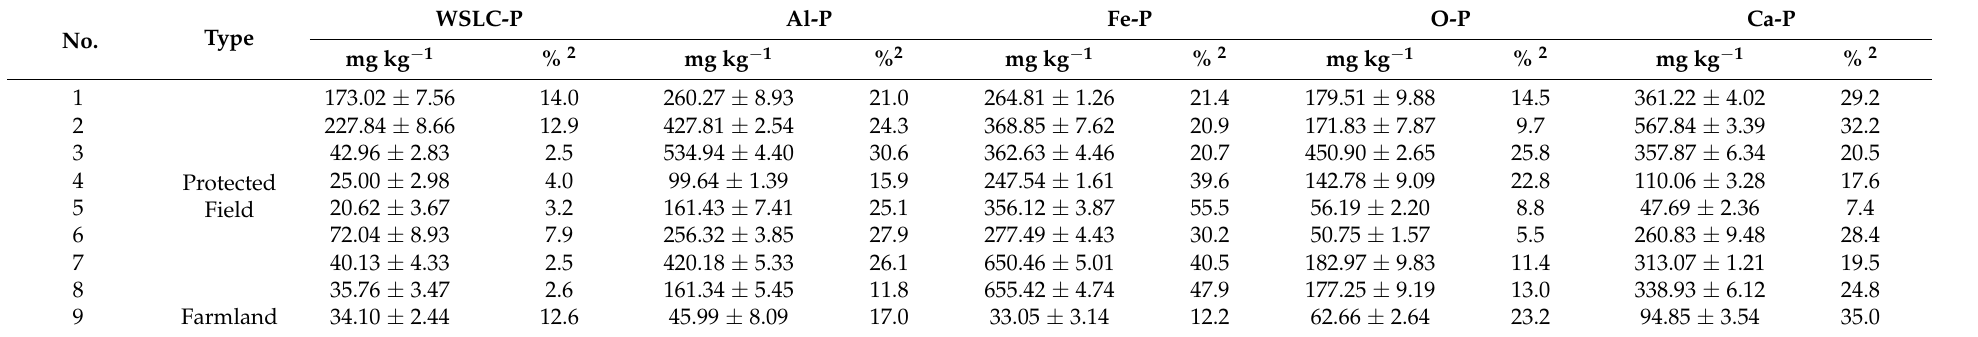
Table 4. The composition of inorganic phosphorus in the top 20 cm of soils collected from protected fields 1 .